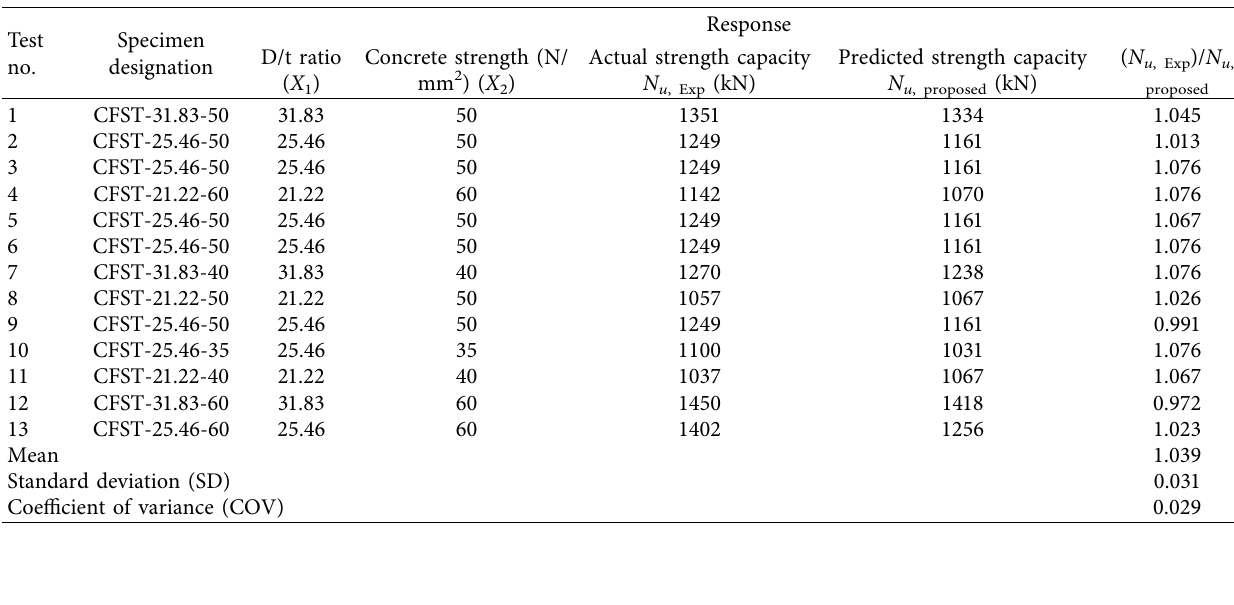
Table 2: Details of DOE (specimen details).